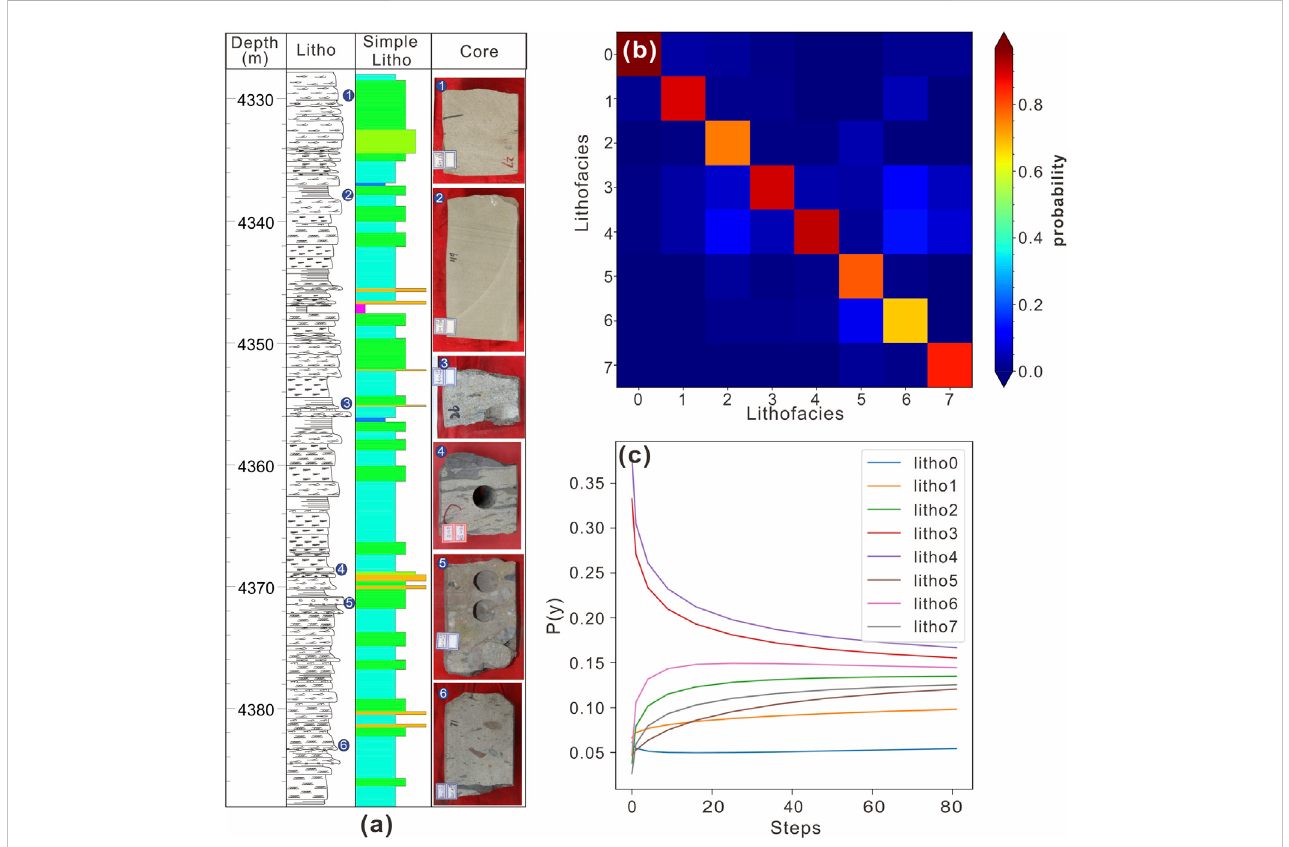
FIGURE 9 The iterative process of obtaining the prior probabilities. (A) The single-well deposition sequence (part of the Zhuang 101 well section is used as an example). Litho refers to lithofacies at the core scale. Simple Litho refers to lithofacies at the welling scale. (B) The color phase diagram of the transfer matrix. (C) The changes in the individual lithofacies probabilities during the iterative